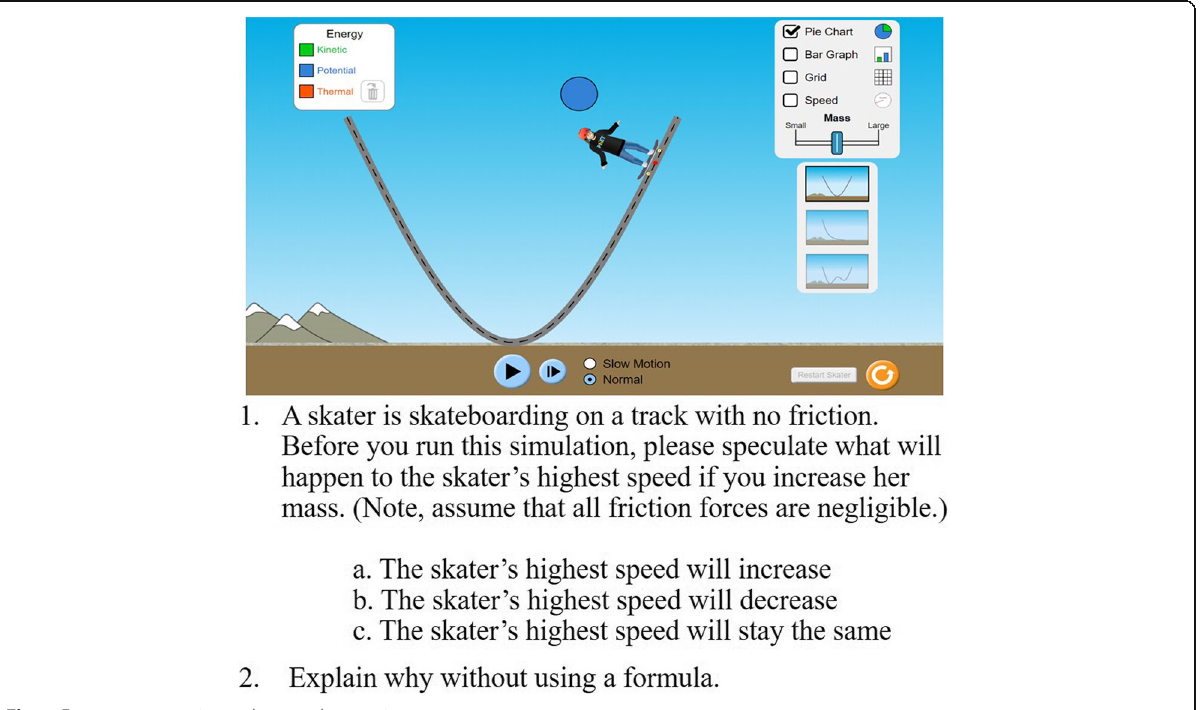
Fig. 1 Energy conservation task example